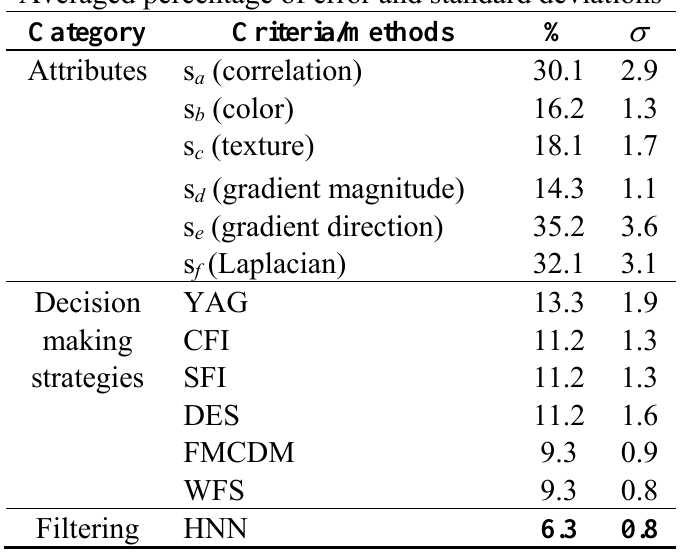
Table 4. Averaged percentage of errors and standard deviations obtained through maximum similarity criteria for each attribute separately and also for the WFS decision making approach and the HNN paradigm against the combined decision making